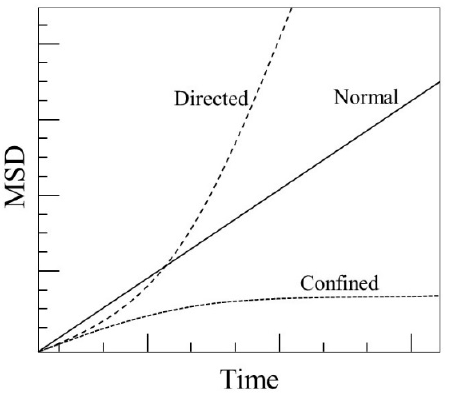
Figure 7. Example of mean square displacement vs. time plots showing examples of normal, directed and confined diffusions for a particle ensemble. Adapted from Reference [50].